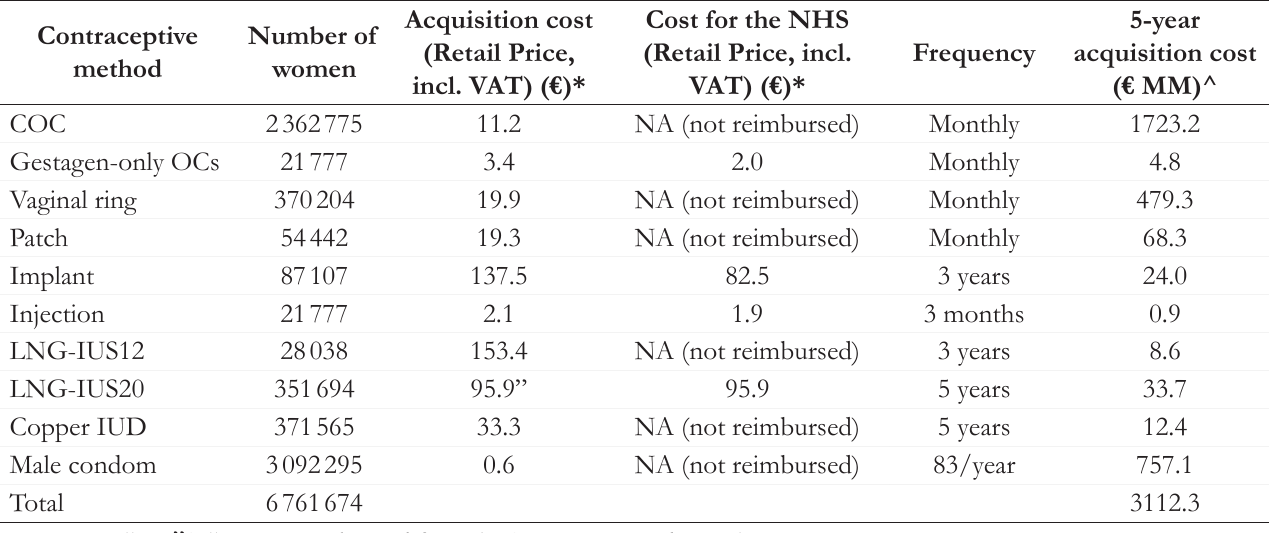
Table 5. Total Cost of Contraceptive Method Acquisition for a 5-year Period Contraceptive